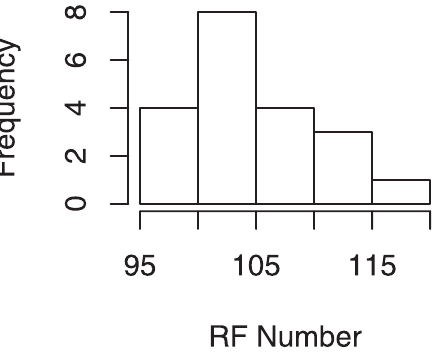
Figure 13. Histogram of RF Numbers when Comparing S. flexneri 2457t versus S. typhi ty2 under Different Parameter Values See the section Robustness with respect to parameter values. DOI: